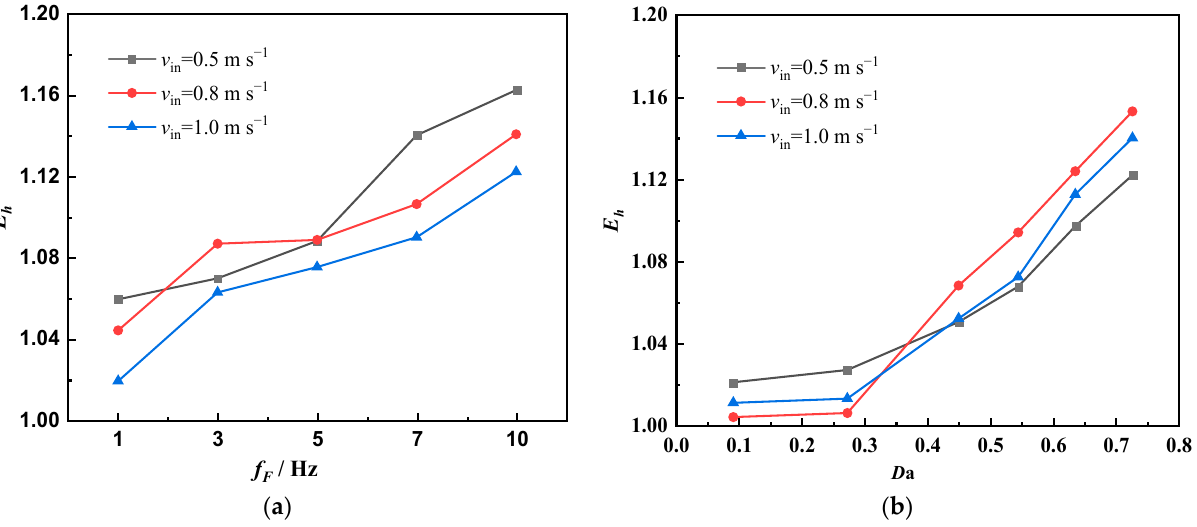
Figure 5. The effects of the natural frequency and the amplitude of the blade on the heat transfer performance: ( a ) frequency at A = 5 mm; ( b ) amplitude at f = 5 Hz.